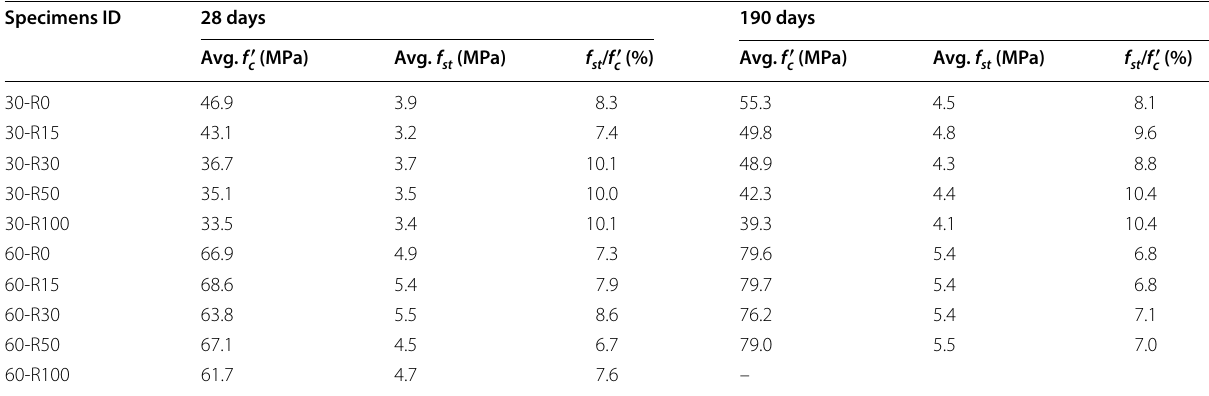
Table 8 Relationship between the tensile strength and the compressive strength according to the curing time.